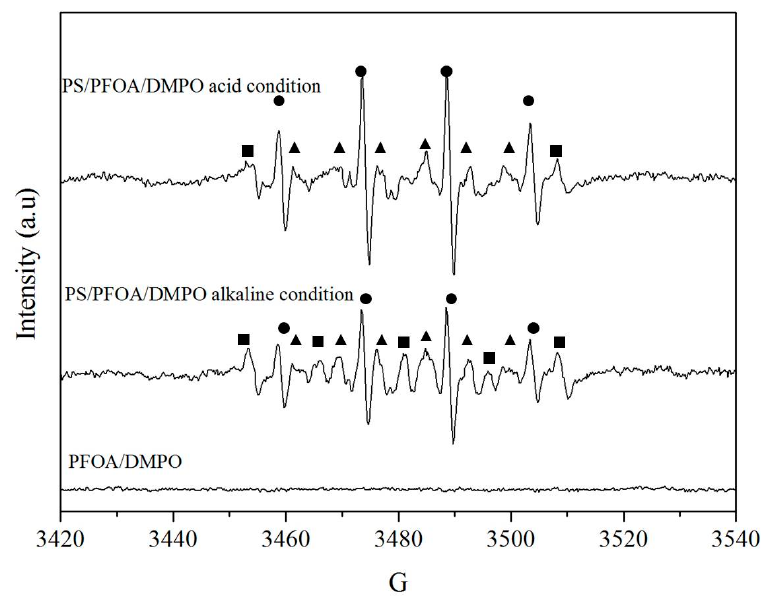
Figure 5. EPR spectra of radical adducts as a function of pH. Experimental conditions: solution pH was adjusted by H 2 SO 4 and NaOH. [PFOA] 0 = 20 μ M; [persulfate] 0 = 2 mM; temperature = 50 °C; reaction time = 10 min; [DMPO] = 100 mM. Circle represents the signal of DMPO–OH, triangle represents the signal of DMPO-SO 4 and square represents signals of unidentified radicals. Table 2. Concentrations of PFCA intermediates formed by PFOA (20 µ M) with a reaction time of 100